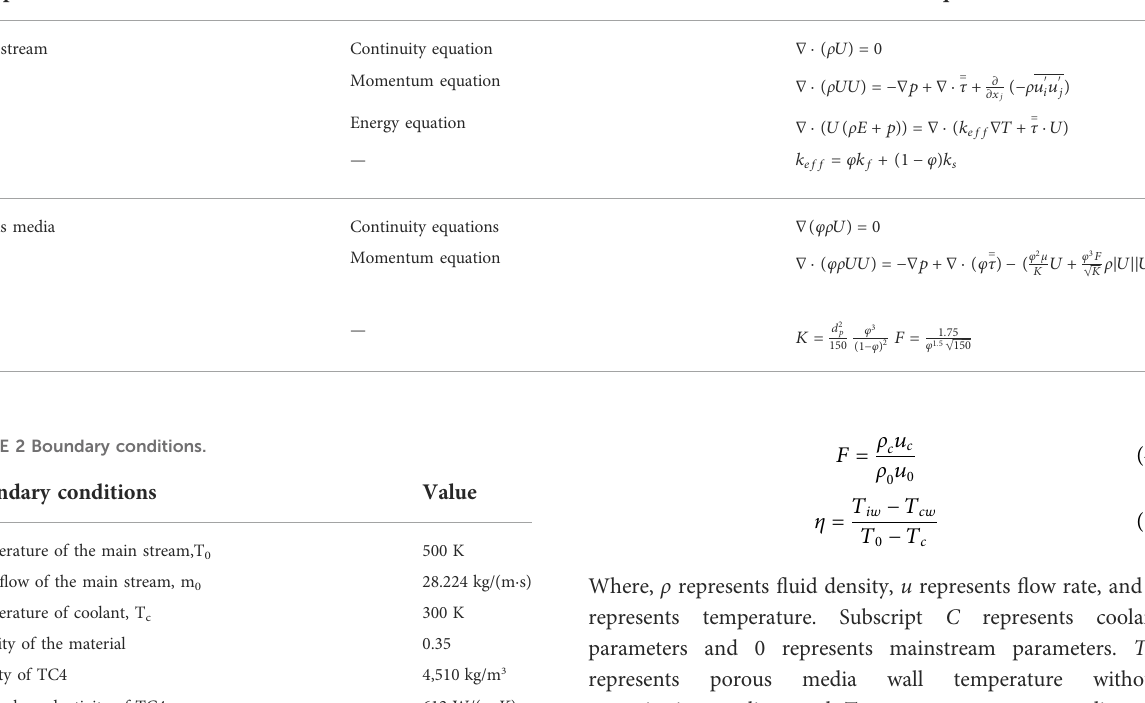
TABLE 1 Conservation equations of the main stream and porous regions. Computational domain